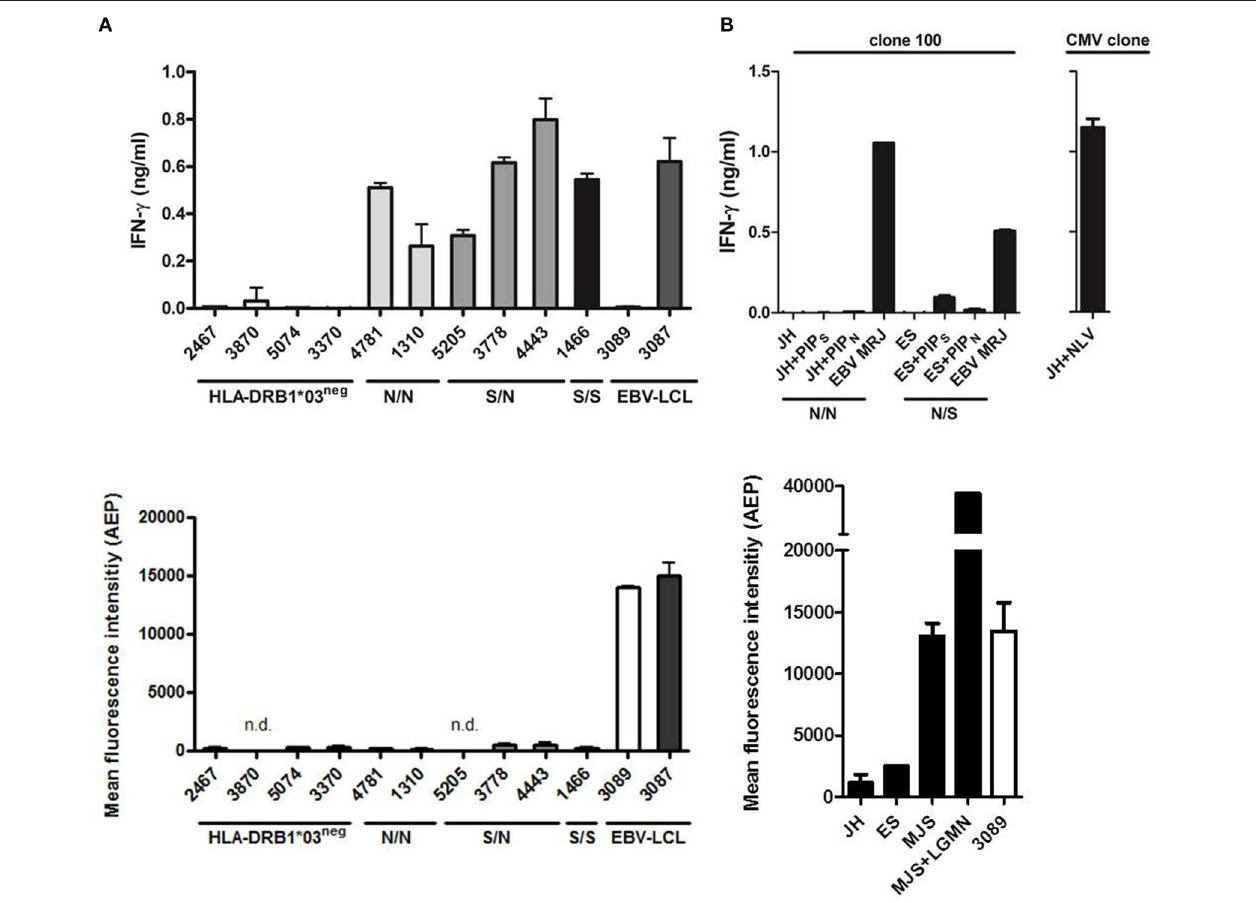
FIGURE 5 | Primary human AML are recognized independent of the SNP for PIP4K2A. (A) Recognition of primary human AML by T-cell clone 100 as tested in IFN- γ ELISA (top panel). PIP4K2A genotypes [N/N (light gray), S/N (dark gray), or S/S (black)] are depicted for HLA-DRB1*03 positive primary AML. EBV-LCL 3087 is derived from the patient from whom T-cell clone 100 has been isolated, and EBV-LCL 3089 is from its stem cell donor. Enzyme activity of AEP has been measured in corresponding AML cell lysates (bottom). n.d., not determined. (B) T-cell recognition of primary human CD34 + cells has been tested by IFN- γ ELISA (top panel). PIP4K2A genotypes (N/N, S/N, or S/S) are depicted. Both patients are typed positive HLA-DRB1*03:01, patient JH is in addition typed positive for HLA-A*02:01 and viability of CD34 + cells is confirmed by recognition of CMV peptide NLV in HLA-A*02:01. Enzyme activity of AEP in CD34 cell lysates is depicted (bottom). One representative of two independent experiments is